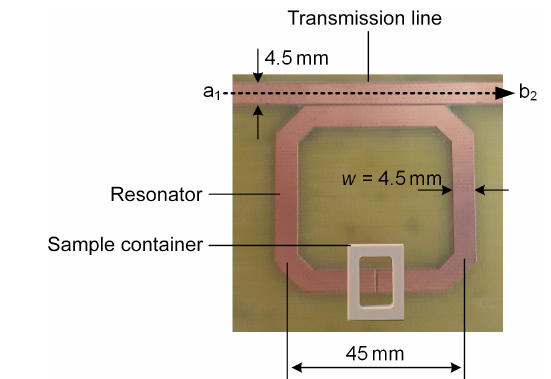
Figure 1. PCB with split-ring resonator.